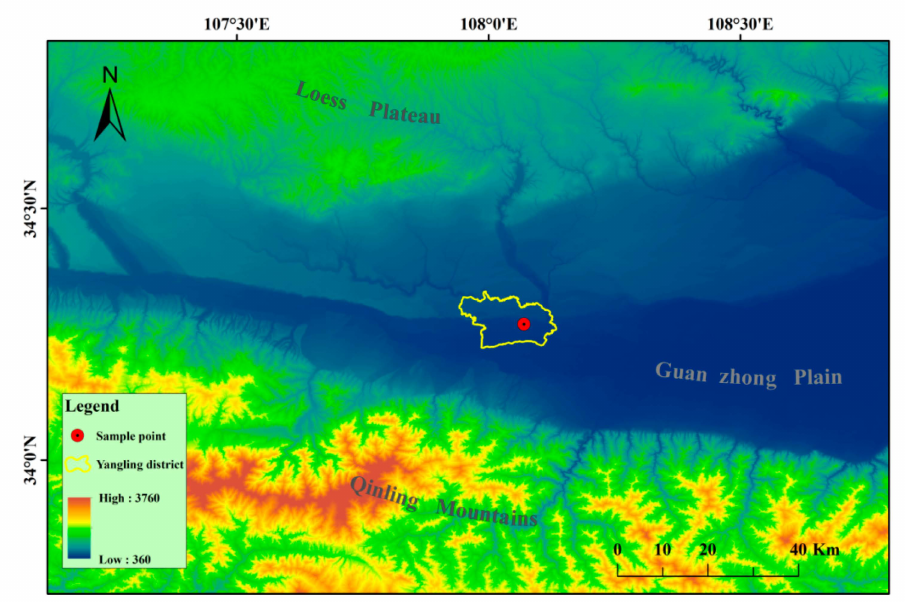
Figure 1. Map of study